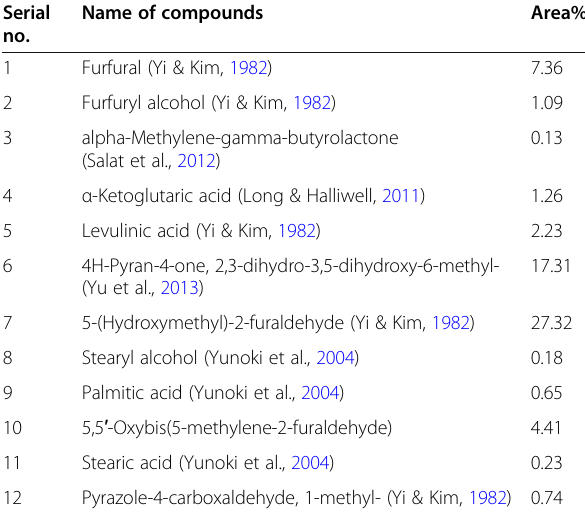
Table 2 List of reported antioxidant components (references are given in round brackets) found in fermented tea